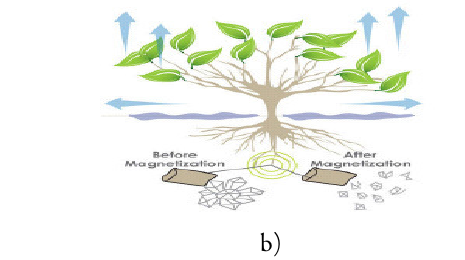
Figure 1. Molecules of water before and after magnetization Source: Babu